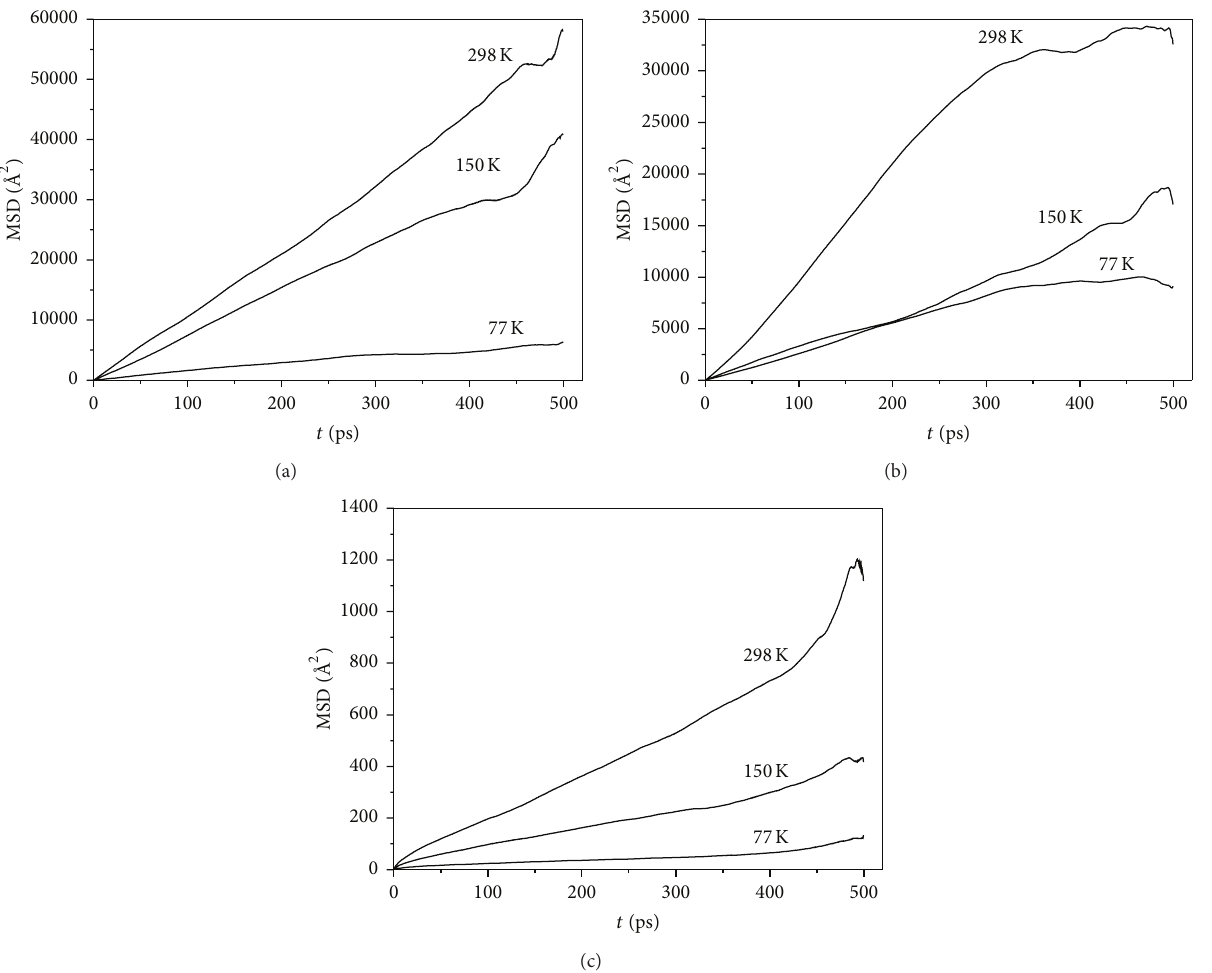
Figure 2: Mean-squared displacement (MSD) of hydrogen for loading 10 molecules/cell at different temperatures; (a) Ca 46 X, (b) Mg 46 X, and (c) Ba 46